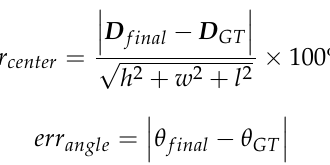
Figure 23. ANFIS truncation of bikes with different levels of difficulty: ( a ) the ANFIS results of one